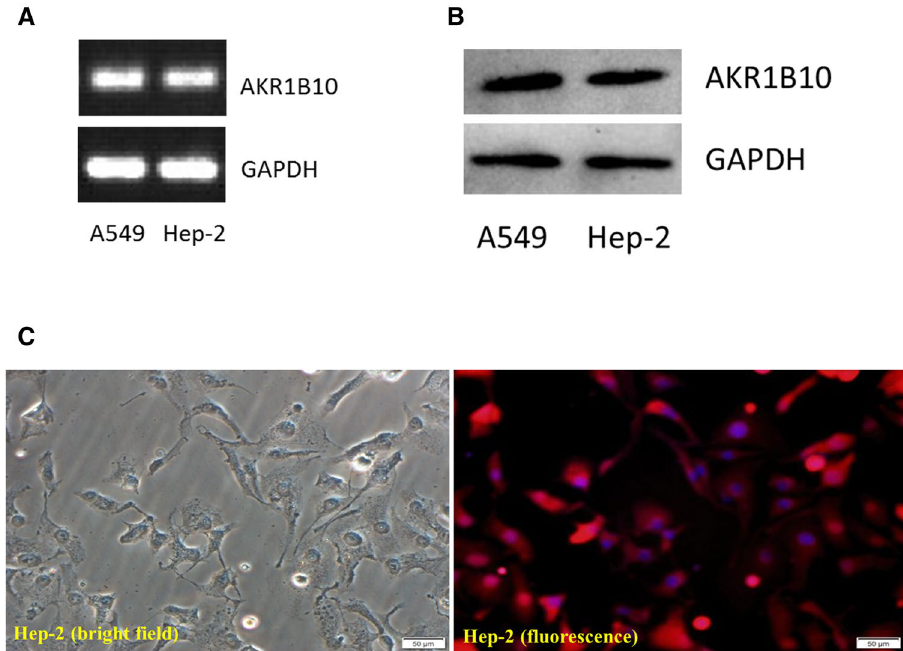
Figure 2. ( A ) Aldosterone reductase family 1 member B10 mRNA expression in Hep-2 cells. ( B ) Aldosterone reductase family 1 member B10 protein expression in Hep-2 cells. ( C ) Aldosterone reductase family 1 member B10 expression in Hep-2 cells (200×). Left panel, bright field; right panel,